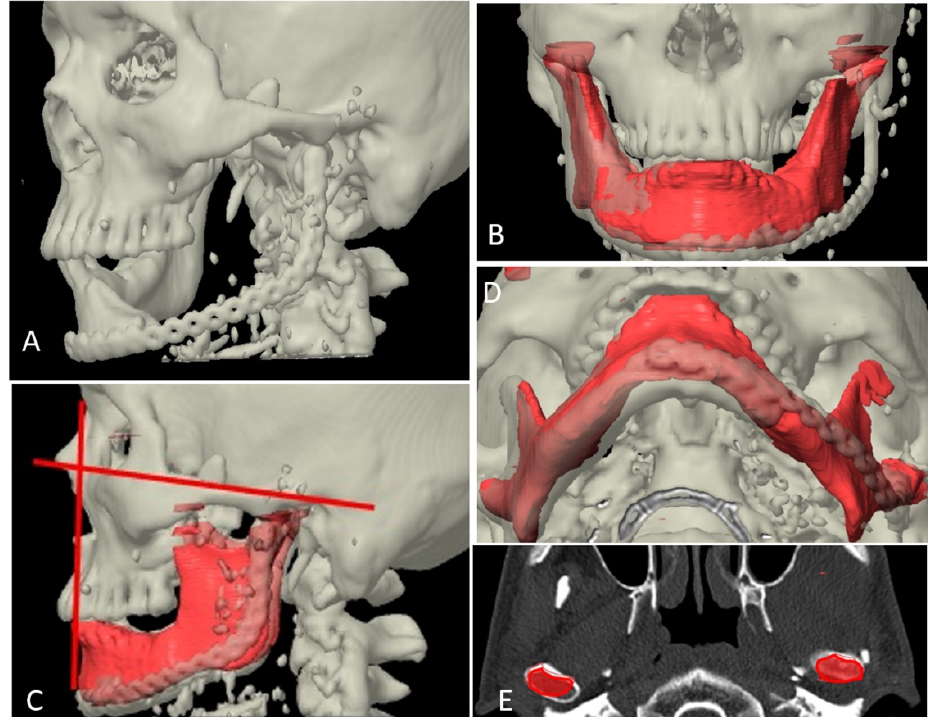
Figure 4. Designing template in category III. ( A ) 3-dimensional view of defect. ( B ) Appropriate mandibular anatomy selected from radiology data bank taking intercondylar distance as horizontal reference (red color). ( C ) Frankfort Horizontal Plane (FHP)-Nasion Pogonion (NPog) angle used as sagittal reference (87 ± 4 degrees being the normal range). ( D ) Arch form coordination approximately matched with maxilla. ( E ) Condylar anatomy of database matching the patient’s original condylar anatomy (red).